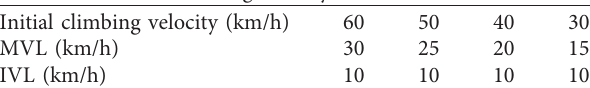
Table 2: Initial climbing velocity in numerical simulation. Initial climbing velocity (km/h)